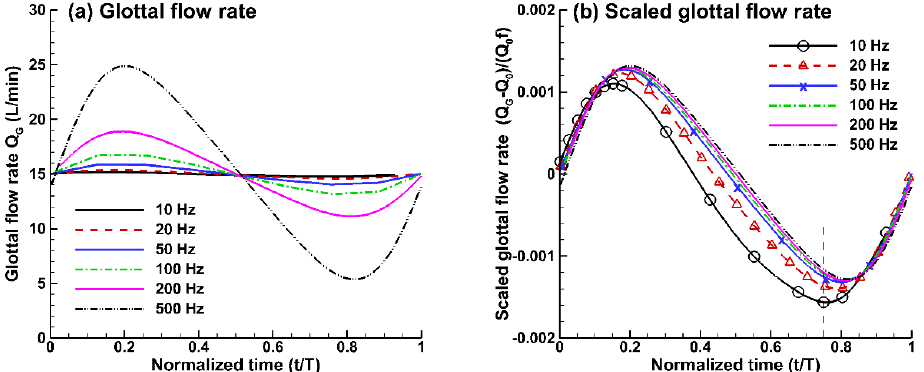
Figure 4. Dynamics of glottal flow at different vibration frequencies: ( a ) glottal flow rate increases with the vibration frequency, and ( b ) normalized glottal flow rate relative to the frequency.